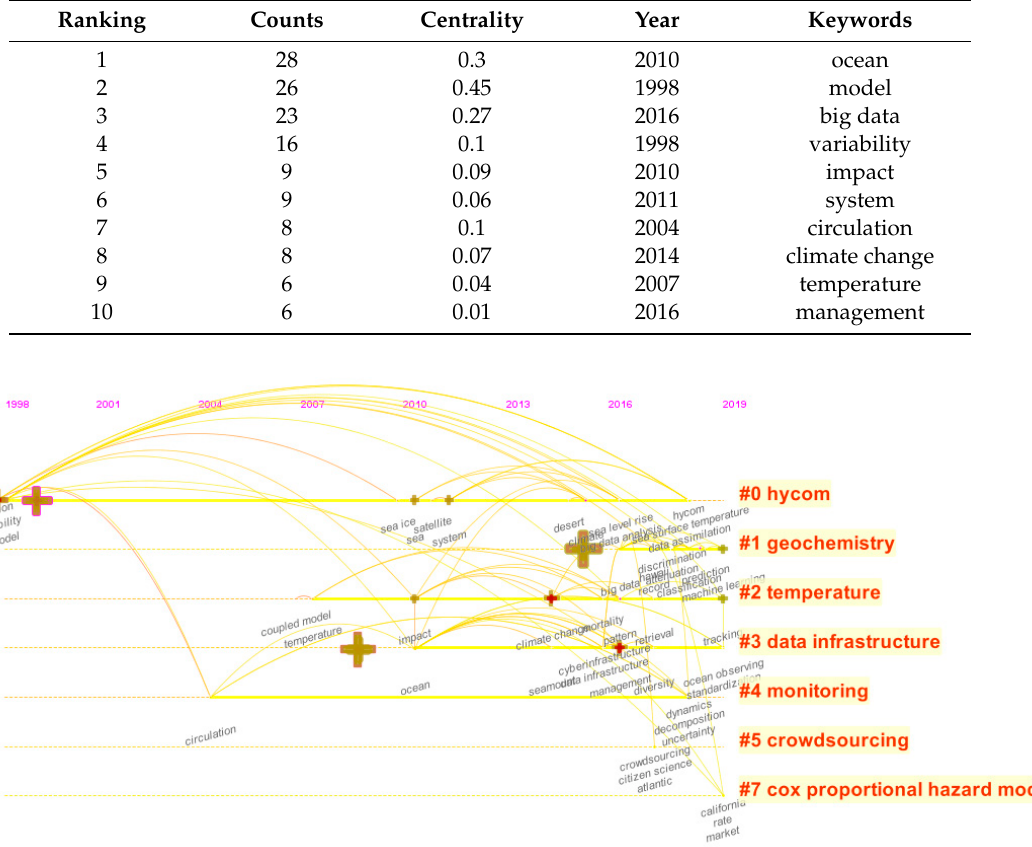
Figure 10. Keyword time zone line map.